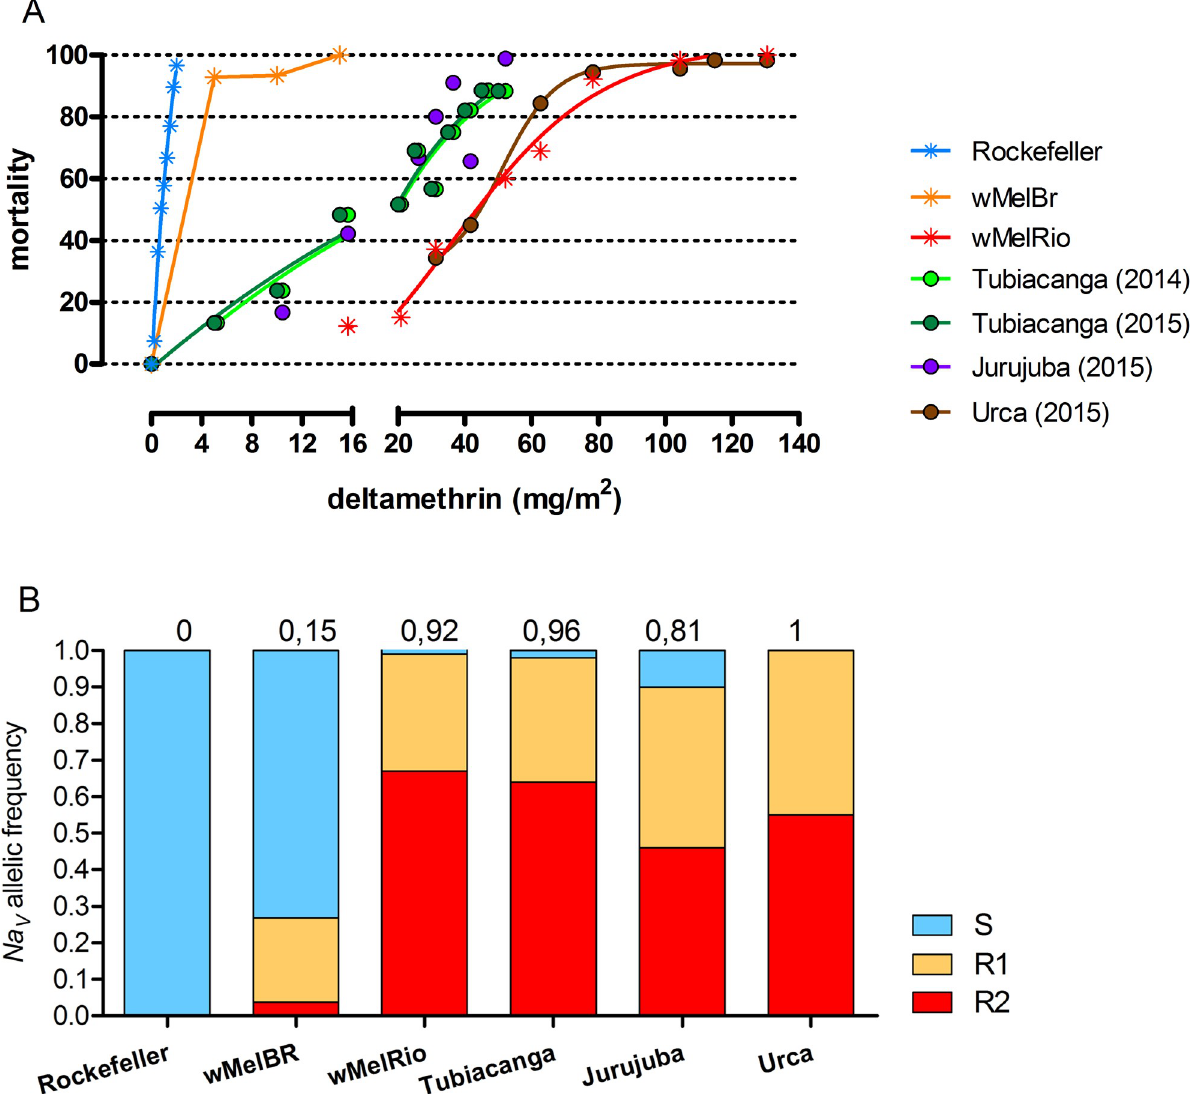
Fig 2. Pyrethroid resistance in two Wolbachia -infected strains ( w MelBr and w MelRio) and three field Aedes aegypti populations (Tubiacanga, Jurujuba and Urca). The susceptible strain Rockefeller was used as a calibration control. A) Mortality profile of Ae . aegypti adult females exposed to the pyrethroid deltamethrin. B) Allelic frequency of population samples; numbers above bars indicate the sum of ‘resistance genotypes’ to pyrethroids, In blue Na V S (1016 Val + + 1534 Phe + ), in orange Na V R1 (1016 Val + + 1534 Cys kdr ) and in red Na V R2 (1016 Ile kdr + 1534 Cys kdr ).